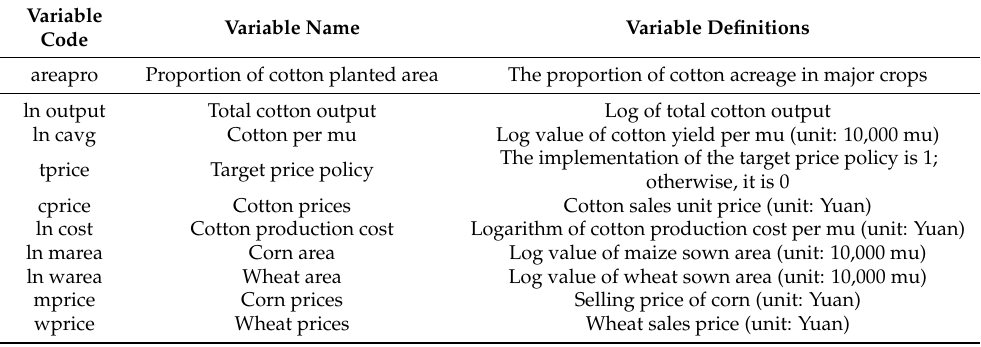
Table 1. Definition of variables and descriptive statistical analysis